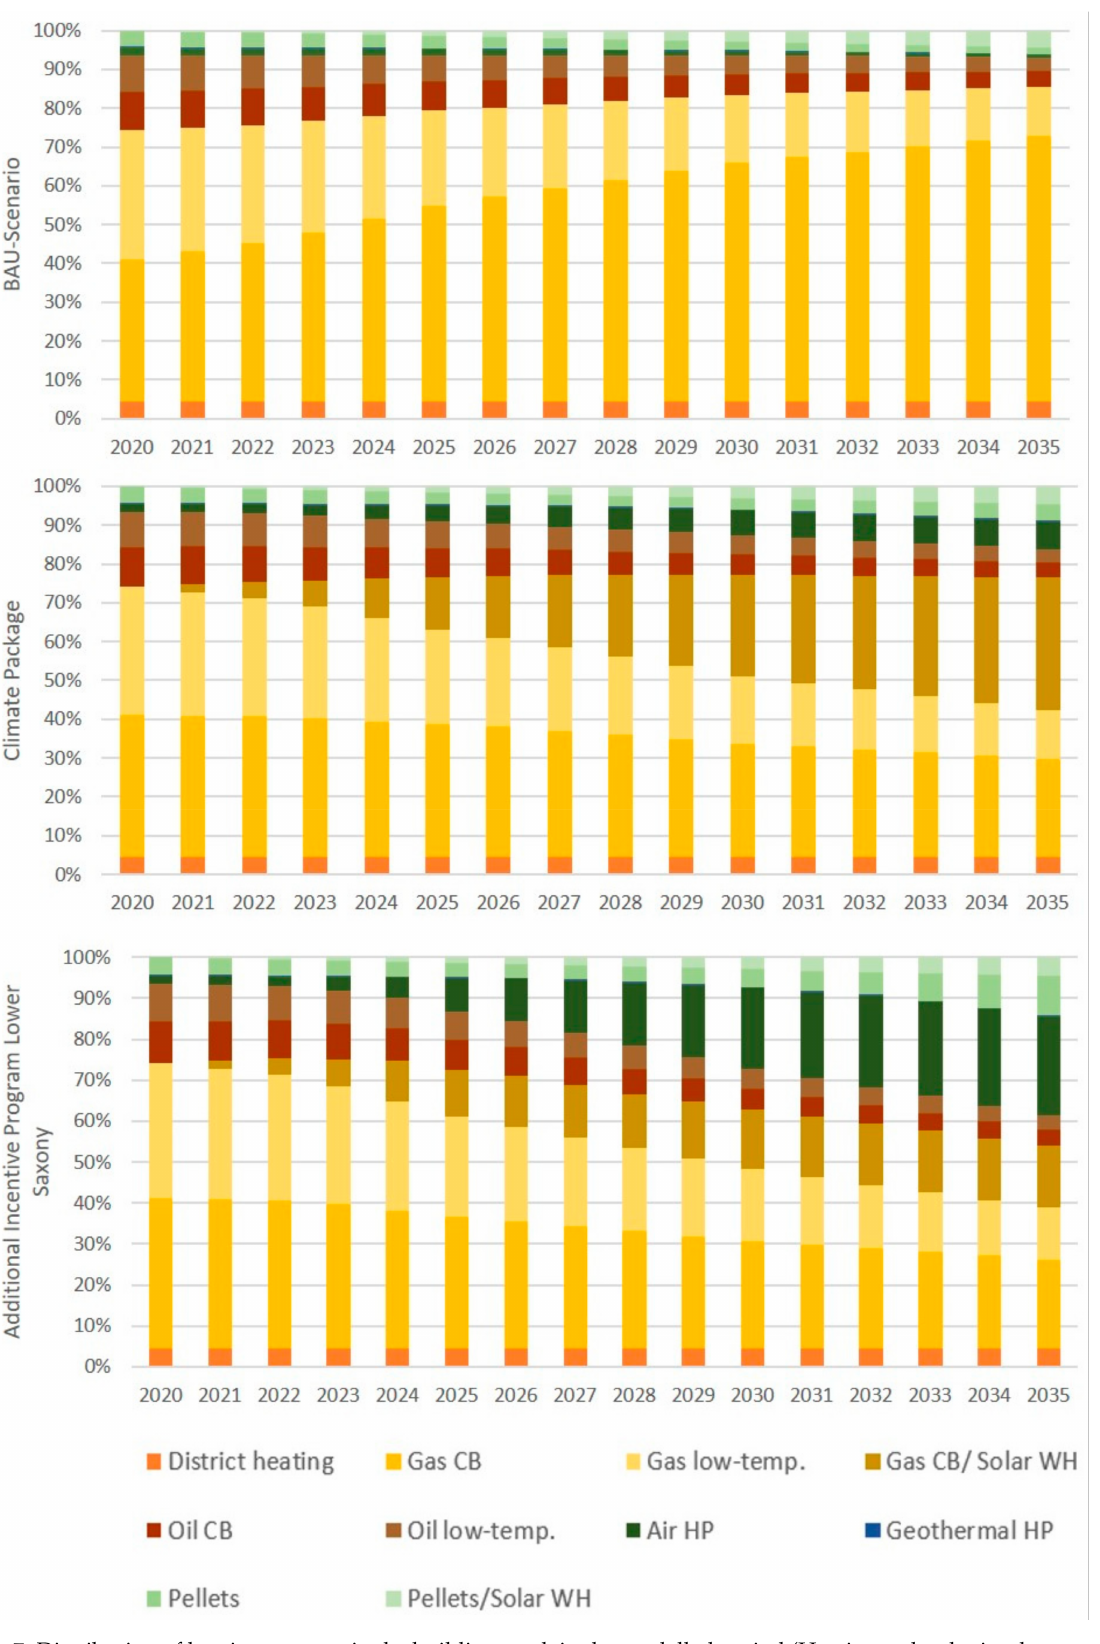
Figure 7. Distribution of heating systems in the building stock in the modelled period (Heating technologies that were not present in the building stock and have not been chosen by the actors in the modelled period were excluded from the